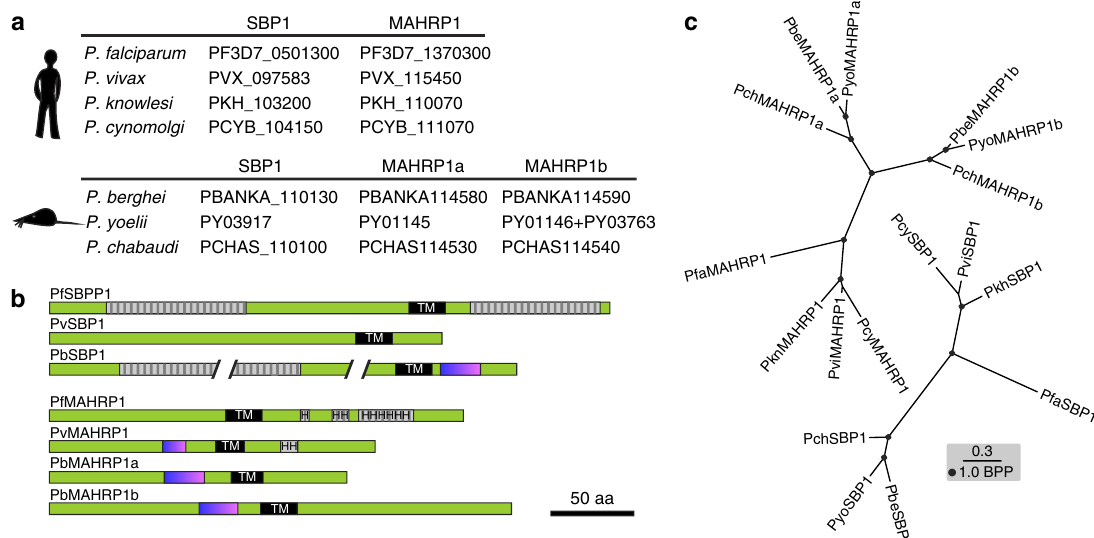
Figure 1 | Orthologues of PfSBP1 and PfMAHRP1 in different Plasmodium species. ( a ) PlasmoDB IDs of the identified SBP1 and MAHRP1 orthologues. Top, human and primate infecting Plasmodium species; bottom, rodent-infecting Plasmodium species. ( b ) Domain structure of selected SBP1 and MAHRP1 orthologues. Hatched grey boxes show repeats; H, histidine-rich regions; black, transmembrane domains (TM); blue/magenta, oligo E/D-K/R stretches. The scale is 50 amino acids (aa). ( c ) Phylogenetic trees of the PfSBP1 and PfMAHRP1 orthologues. Scale bar indicates 0.3 expected substitutions per site; BBP, Bayesian posterior